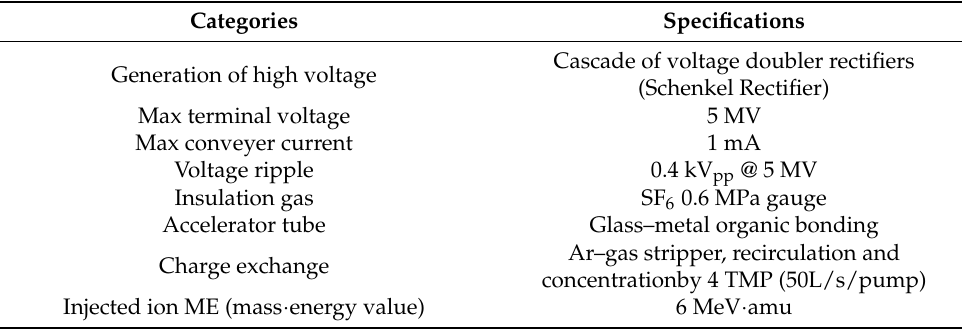
Figure 2 . Tandem accelerator at WERC. Figure 2. Tandem accelerator at WERC. Table 1 . Specifications of tandem accelerator. Table 1. Specifications of tandem